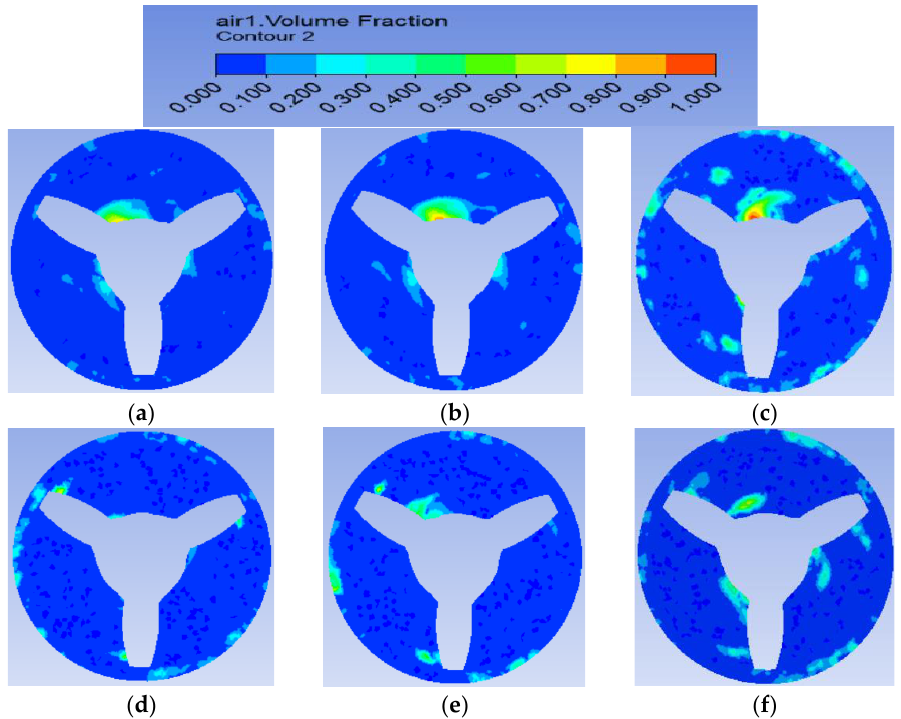
Figure 12. Cross-sectional cloud diagram of the liquid oxygen vapor volume fraction of two different Zwart models at three temperatures. ( a ) Iso-Zwart T = 86 K; ( b ) Iso-Zwart T = 90 K; ( c ) Iso-Zwart T = 95 K; ( d ) Mod-Zwart T = 86 K; ( e ) Mod-Zwart T = 90 K; ( f ) Mod-Zwart T = 95 K. As shown in Figure 13, it is the cloud diagram of the liquid oxygen vapor volume fraction iso-surface (equivalent number is 0.5) simulated under the conditions of two different Zwart models at three different temperatures of 86 K, 90 K and 95 k.